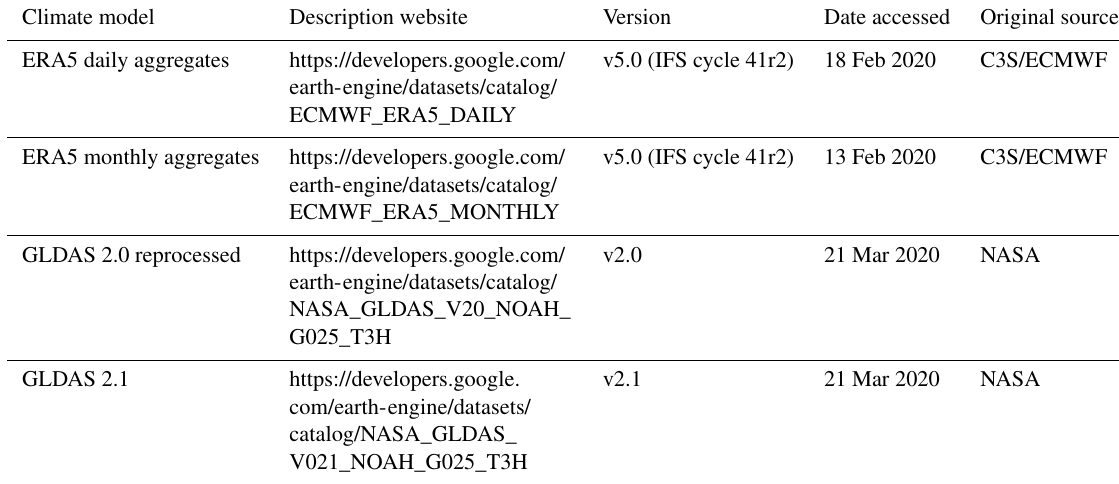
Table A3. Google Earth Engine climate model